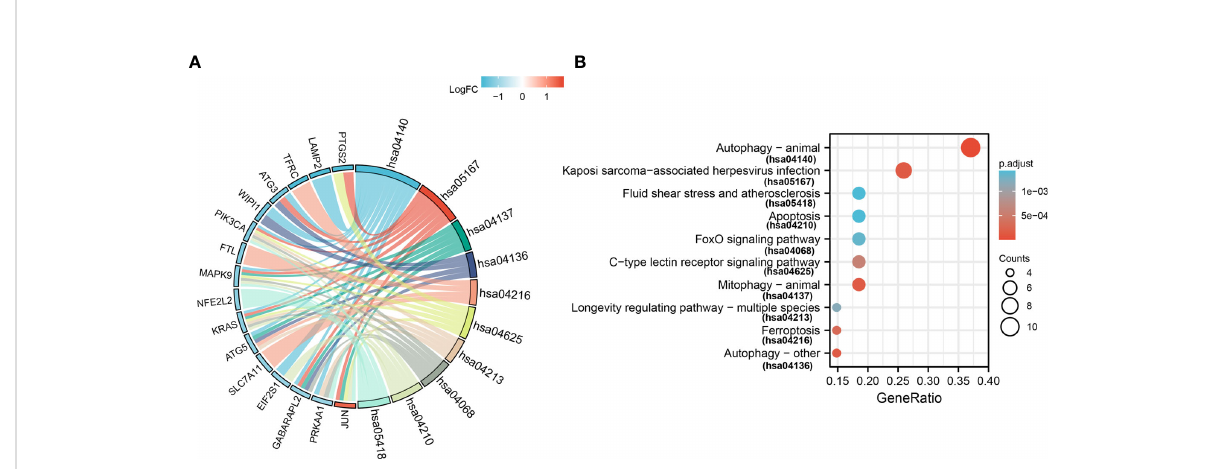
FIGURE 6 Kyoto Encyclopedia of Genes and Genomes analysis (KEGG) of 33 ferroptosis-related DE-mRNAs. Chord (A) and Bubble plot (B) of enriched KEGG terms of 33 ferroptosis-related DE-mRNAs. Y-axis: name of the KEGG signaling pathway; X-axis: percentage of the number of genes assigned to a term among the total number of genes annotated in the network; Bubble size, number of genes assigned to a pathway; Color: enriched -log10( P -value); Red bubble: indicates a greater signi fi cance